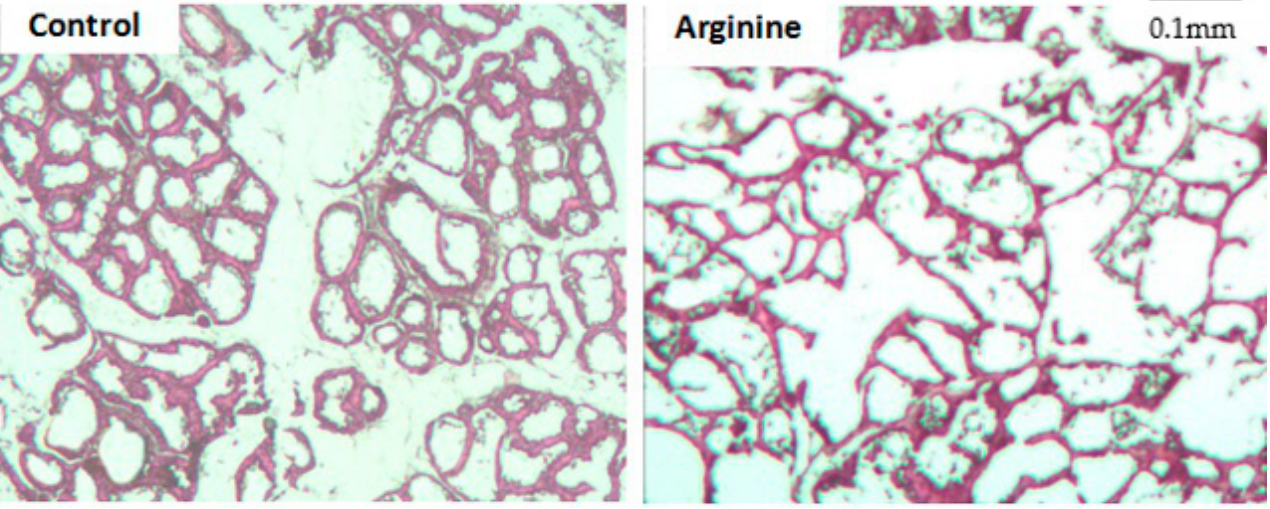
Figure 1. Rat mammary acinar histological section (400×).